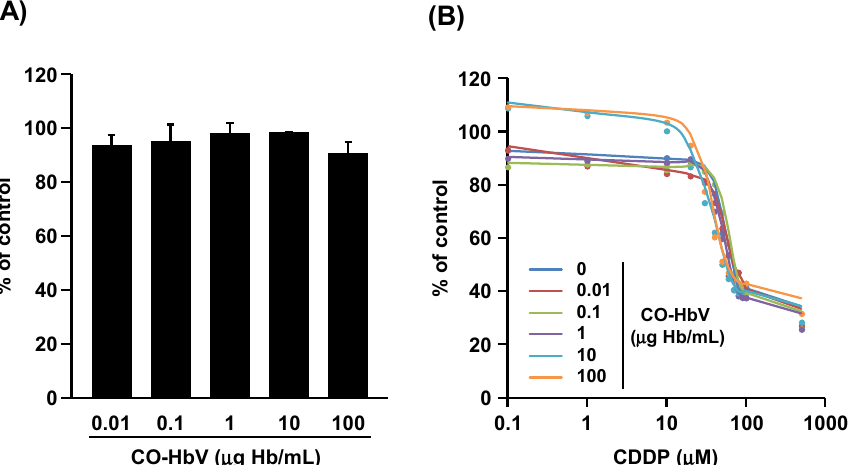
Figure 5. The effects of carbon monoxide (CO)-loaded Hemoglobin-vesicle (CO-HbV) on tumor cells. ( A ) Dose-dependent cytotoxicity effect of CO-HbV on B16-F10 melanoma cells. ( B ) The inhibitory effects of CO-HbV on anti-tumor activity of cisplatin (CDDP) toward B16-F10 melanoma cells. The data represent the mean ± S.D. ( n = 3) .